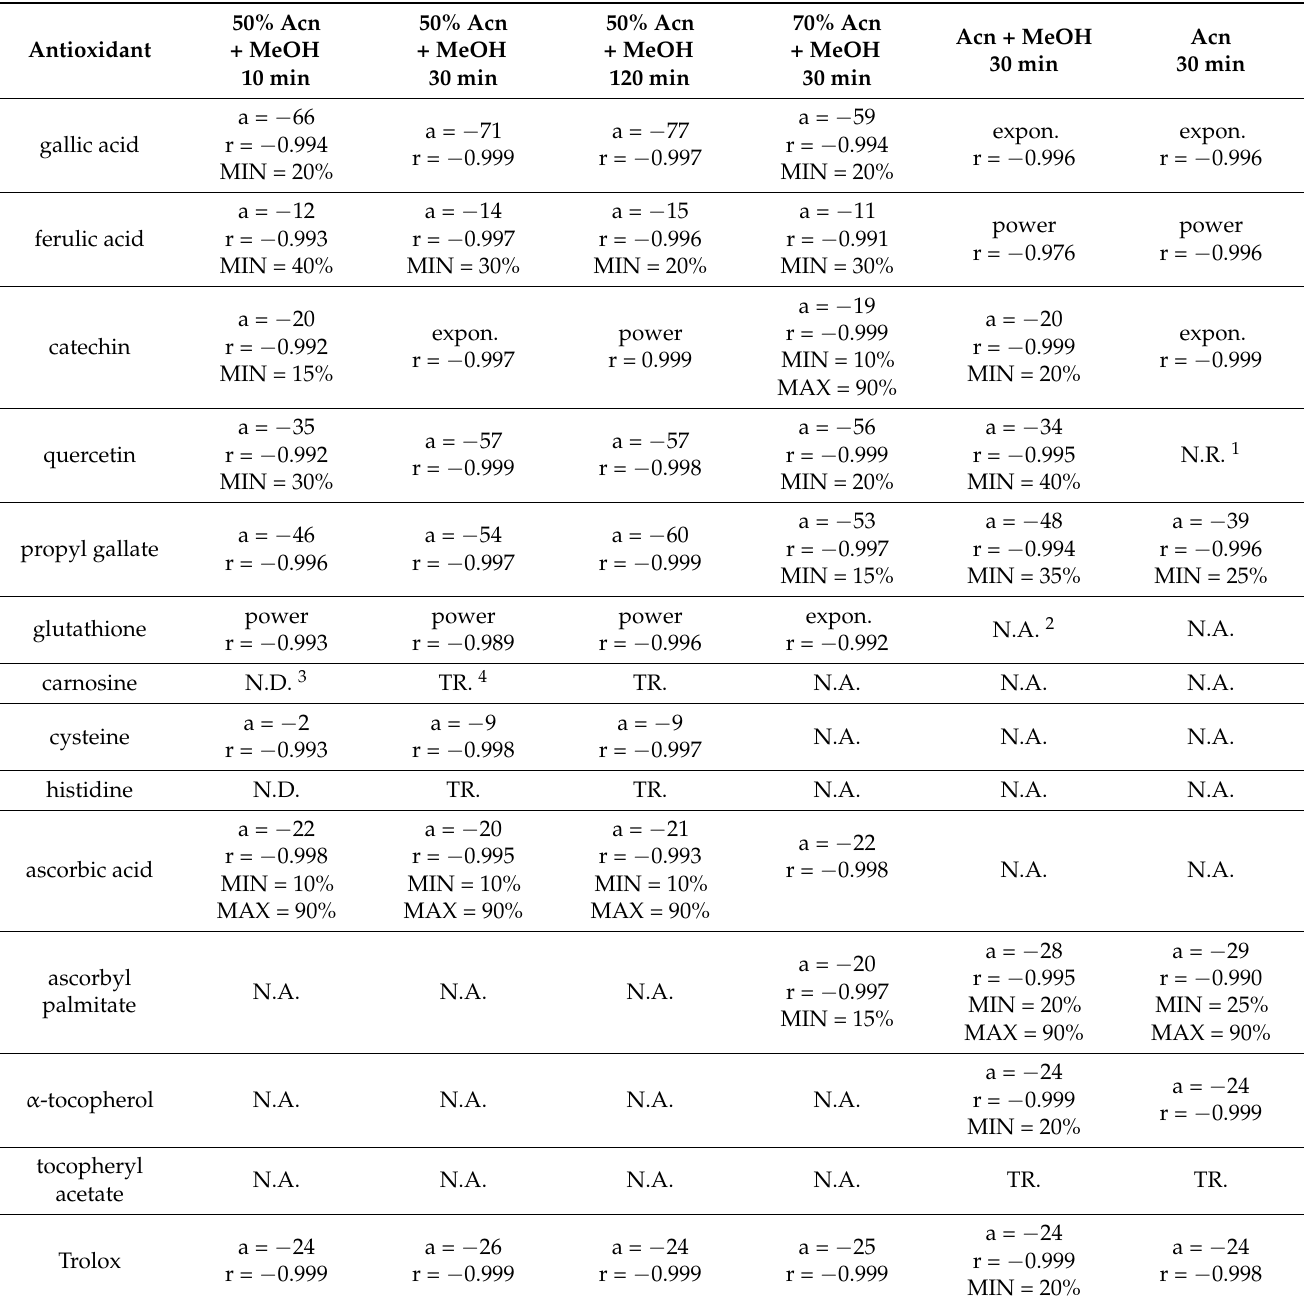
Table 2. Linear and non-linear relationships obtained for different antioxidant concentrations ( µ M) applied against DPPH radicals in acetone or aqueous acetone after standard and modified reaction times (radical solution in methanol or acetone). In case of linear relations, slope (a), correlation coefficient (r) and lower/upper linearity limits if occurring (MIN/MAX–as % of A contr ) were shown; in case of a non-linear relationship, equation type and correlation coefficient were